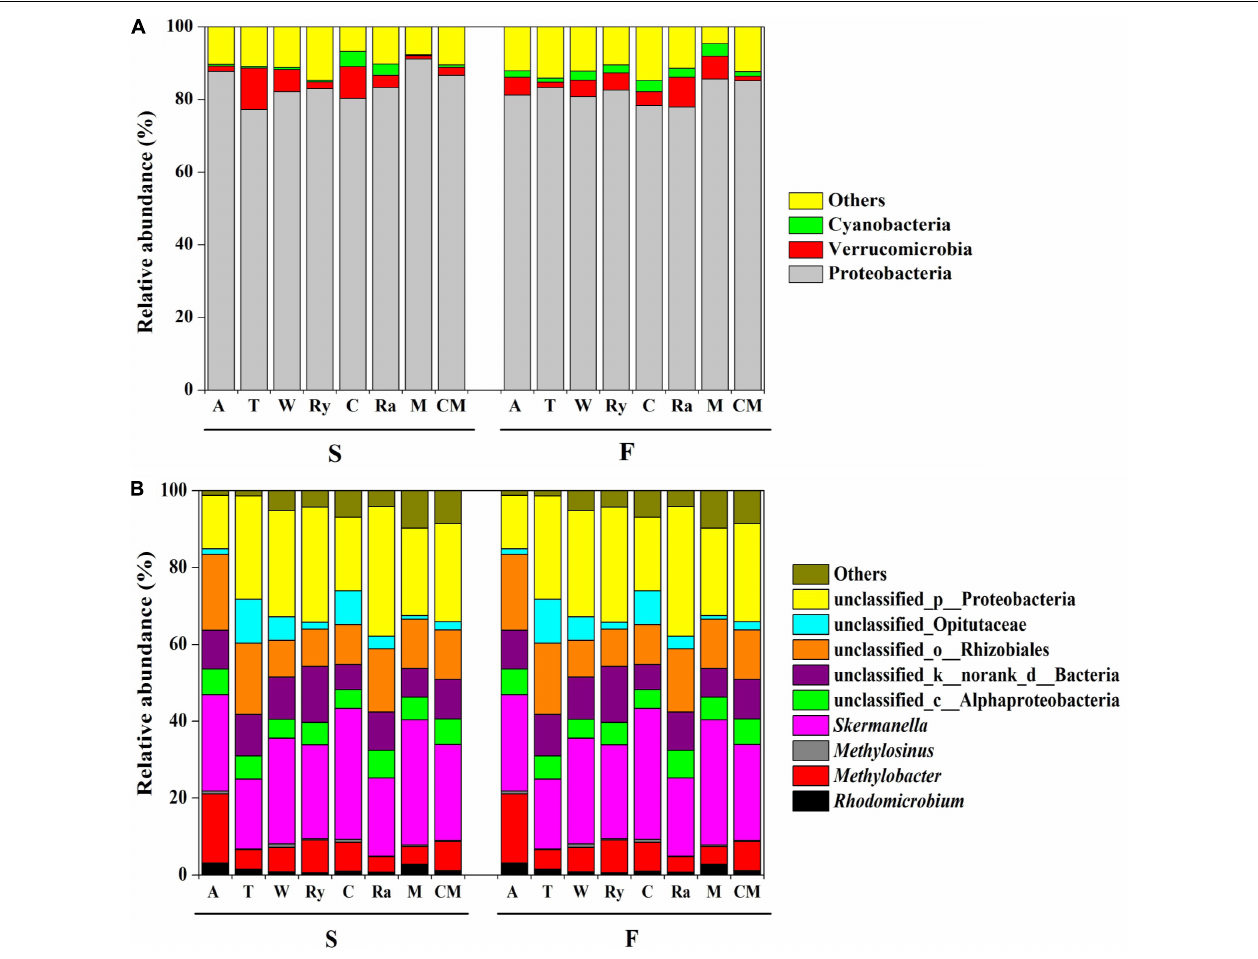
FIGURE 4 | Relative abundances (%) of (A) diazotrophic phyla and (B) genera among eight cropping systems in the spring (S) and fall (F) cropping seasons. “Others” includes phyla and genera below 0.5% relative abundance.